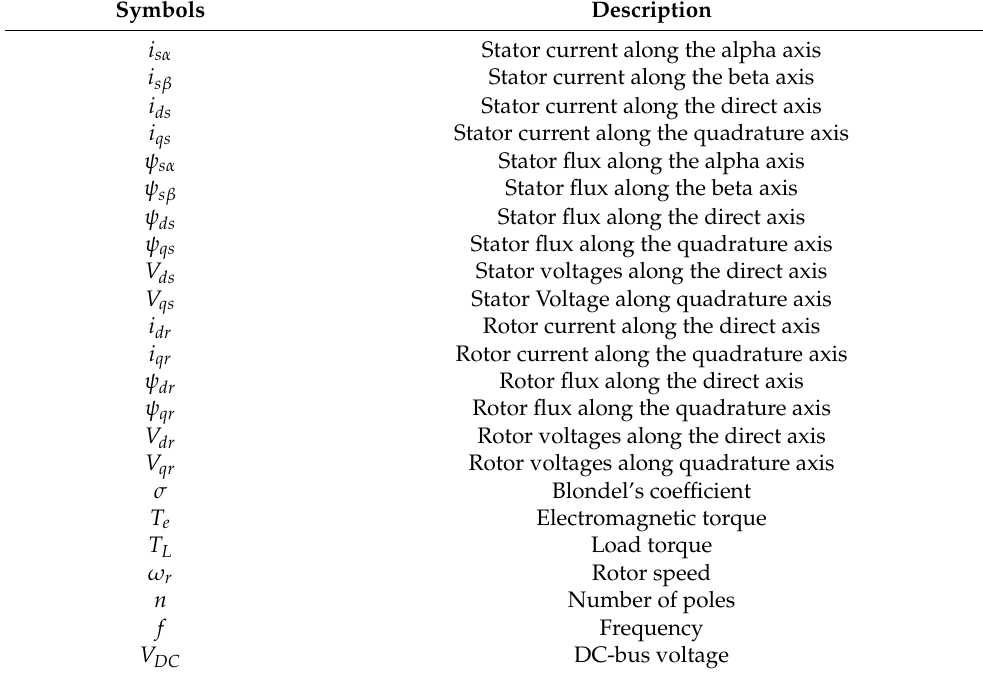
Table 1. List of parameters.